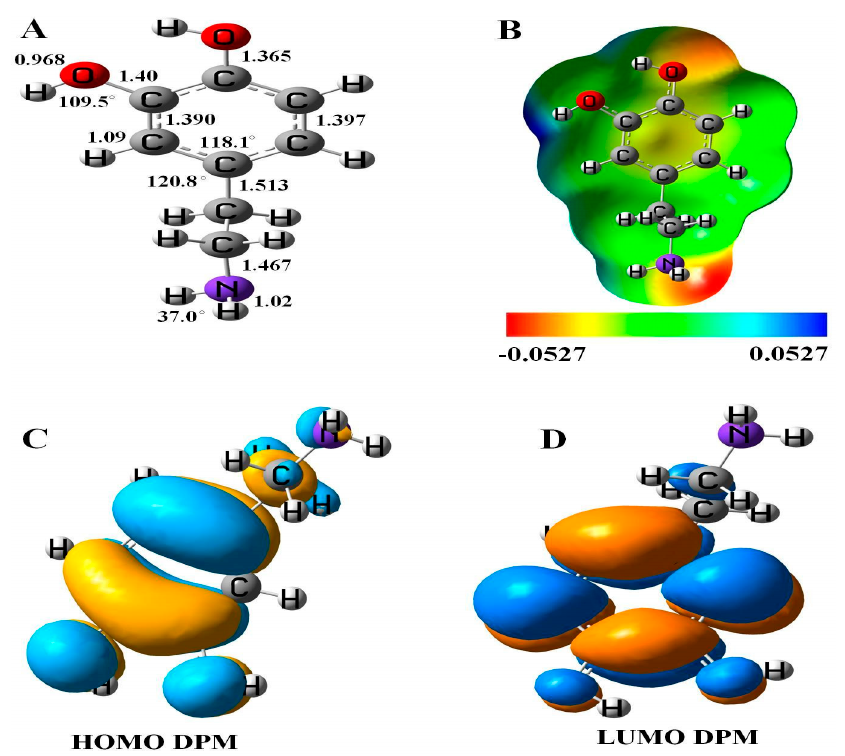
Figure 1. ( A ) Geometry, ( B ) molecular electrostatic potential surface (MEP) plot, ( C ) highest occupied molecular orbital (HOMO), and ( D ) lowest unoccupied molecular orbital (LUMO) of dopamine (DPM).